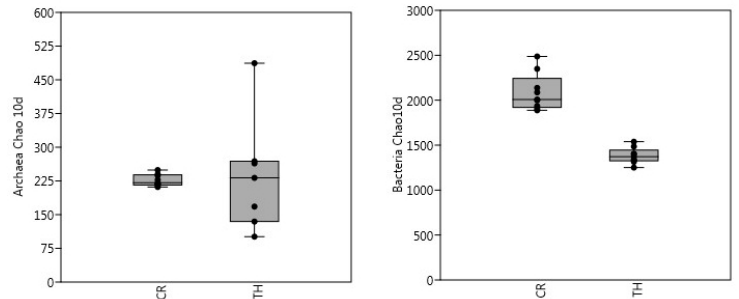
Figure 2. Archaeal and bacterial richness (Chao1) as measured from amplicon sequence data in batch bottles with BW and control (CR), freeze-thaw (FR) and thermally (TH) treated inocula. Length of the experiment was 28 days (treatments CR, FR and TH, figures above) and 10 days (treatments CR and TH, figures below). For each sample, the 25–75 percent quartiles are drawn using a box. The median is shown with a horizontal line inside the box. The minimal and maximal values are shown with short horizontal lines ("whiskers"). The dots are the sample values included.